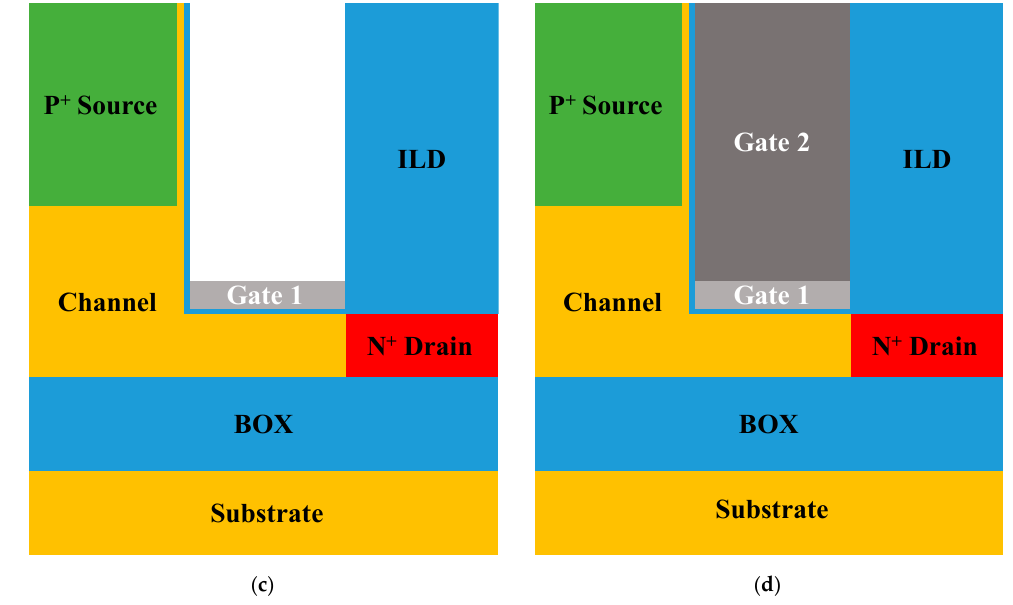
Figure 9. Key process steps for stacked gate L-shaped TFET. ( a ) Gate 2 is deposited by atomic layer deposition (ALD); ( b ) Gate 2 chemical mechanical polishing (CMP); ( c ) etch-back process; ( d ) Gate1 ALD & CMP.